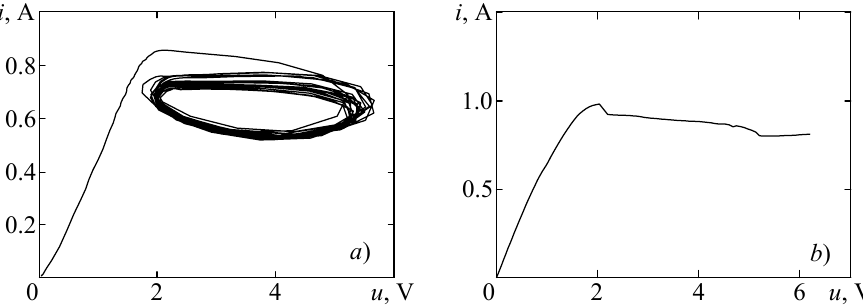
Fig. 3. Continuously recorded voltage and current on the Gunn diode 3A702 (the inductance of the connecting line is 230 nH) shown in the coordinates “voltage – current” ( a ) and the I-V characteristic measured with a low-pass filter in the presence of self-excitation of the connecting circuit ( b